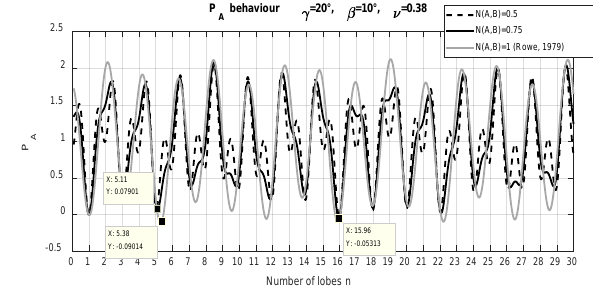
Fig. 7. Geometric stability parameter for γ =20°, β =10° and ν =0.38